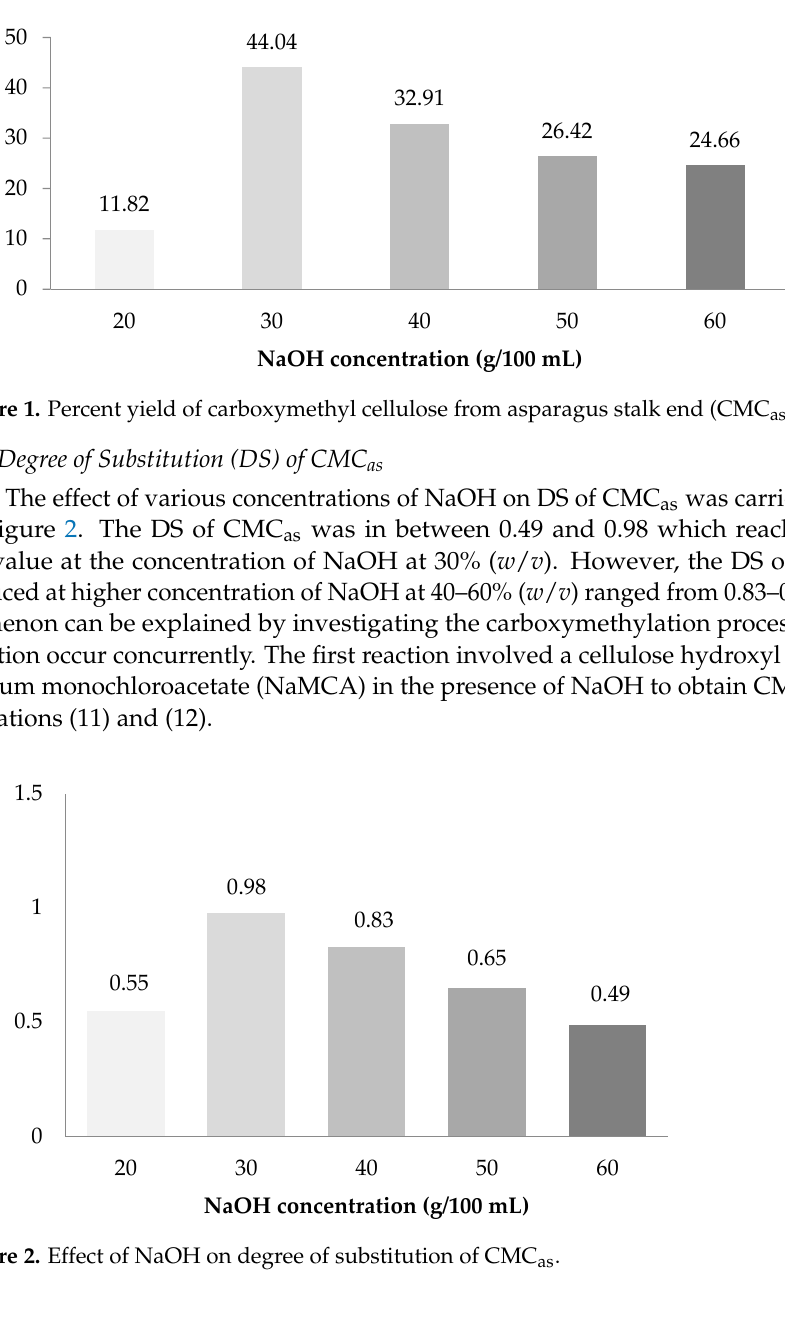
Figure 2. Effect of NaOH on degree of substitution of CMC as .